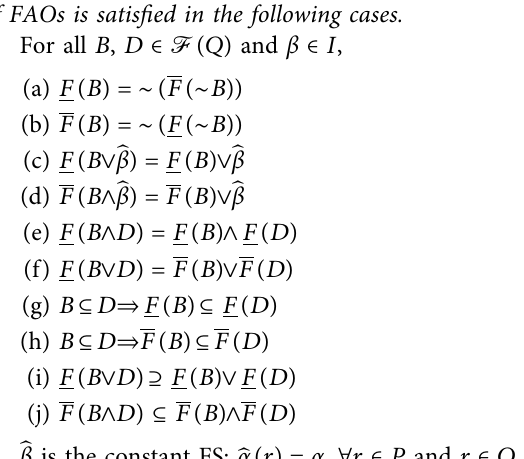
Figure 1: Cay F ( Z